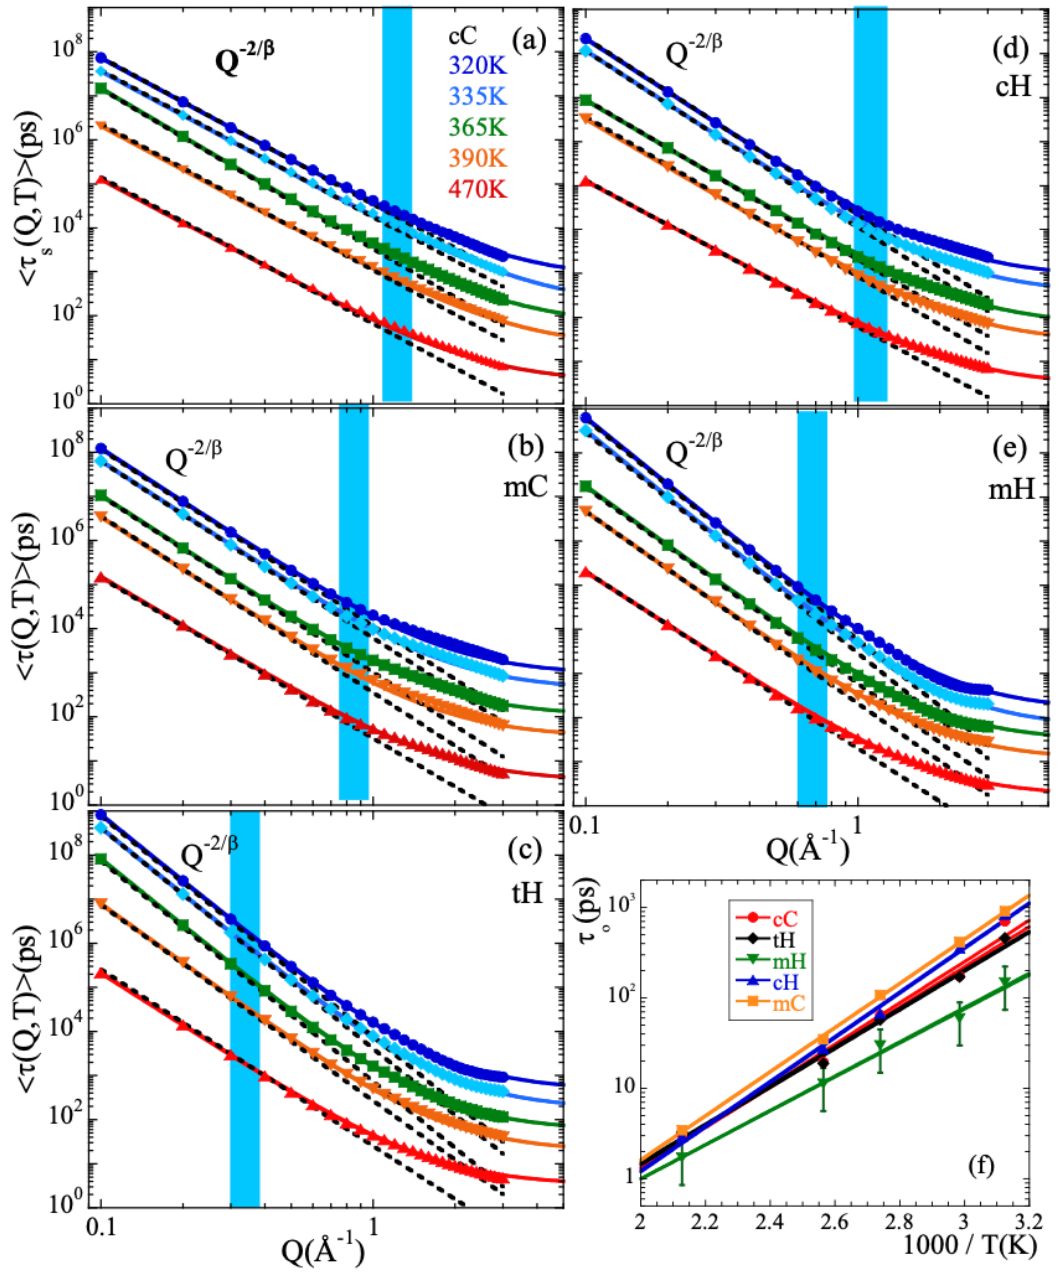
Figure 5. ( a – e ) Momentum transfer dependence of the average characteristic times obtained for the different temperatures (see color code in Panel ( a )) for the different atomic species: main-chain carbons ( a ); methyl-group carbons ( b ); total hydrogens ( c ); main-chain hydrogens ( d ); methyl-group hydrogens ( e ). Continuous lines are fits of the anomalous jump diffusion model [Equation (15)]. Dotted lines show the asymptotic Gaussian law [Equation (14)]. In both cases, the values of (cid:104) β (cid:105) Q shown in Figure 3b have been used. Shadowed areas indicate the Q -range where deviations from the Gaussian approximation start to develop. ( f ) Temperature dependence of the elementary characteristic time involved in the anomalous jump diffusion model for the different kinds of atoms in PIB. Representative error bars are shown for the mH species. Solid lines are fits of Arrhenius equations with activation energy E AJD a (see Table